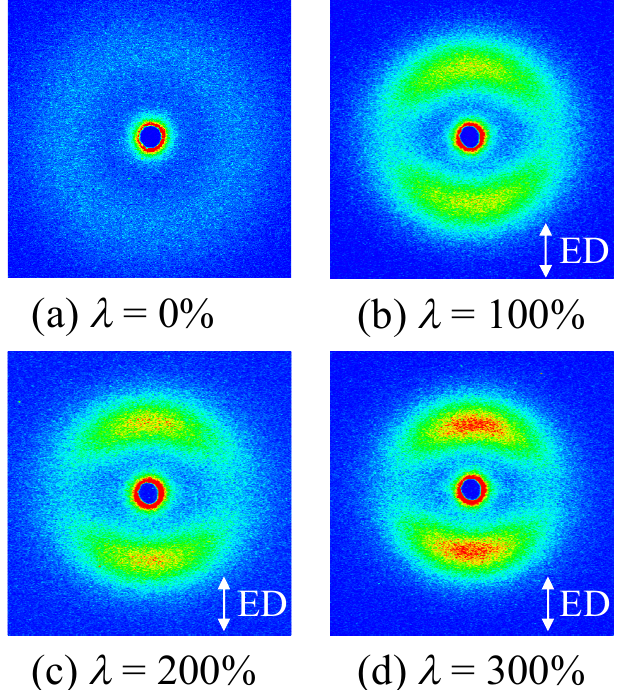
Figure 2. Two-dimensional SAXS patterns of the heat-elongated TPU films obtained at 150 °C at various elongation ratios λ ; ( a ) λ = 0%, ( b ) λ = 100%, ( c ) λ = 200%, ( d ) λ = 300%.